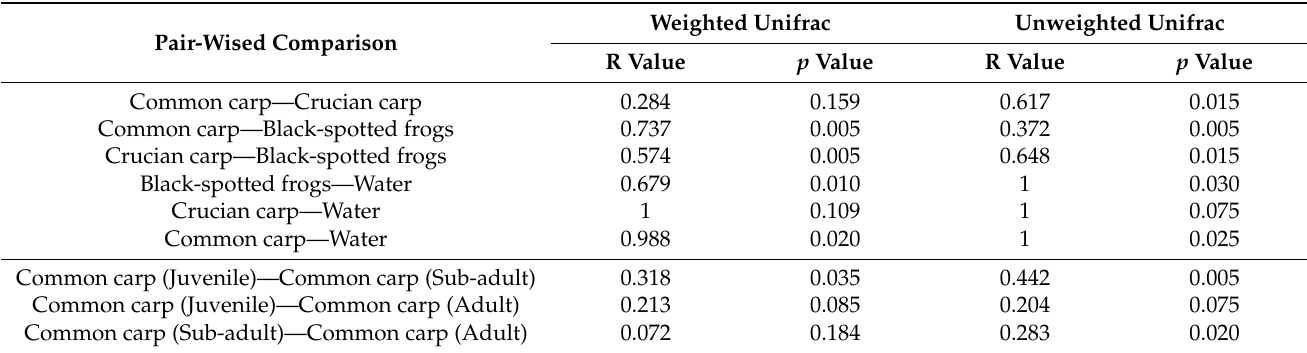
Table 1. Results of ANOSIM tests with 999 permutations on the gut microbial community between three sympatric aquatic species and water environment collected in July and between the three developmental stages in common